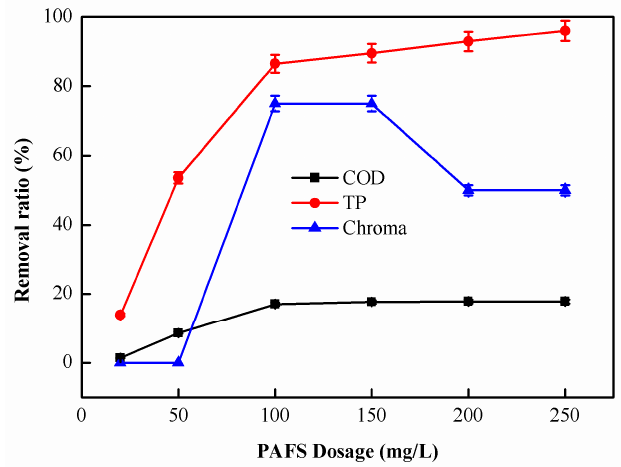
Figure 3. Effect of PAFS dosage on coagulation performance.